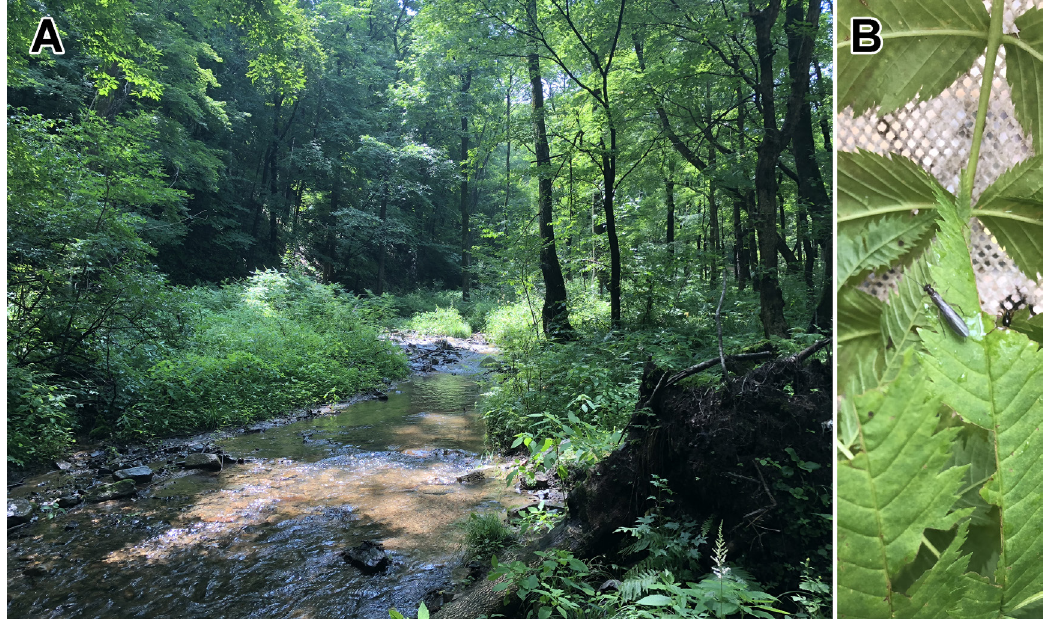
Fig. 13. Habitat of Amphinemura jiaoheensis sp. nov. in China, Jilin Province. A . The unnamed stream. B . Adult habitus when captured by a sweeping